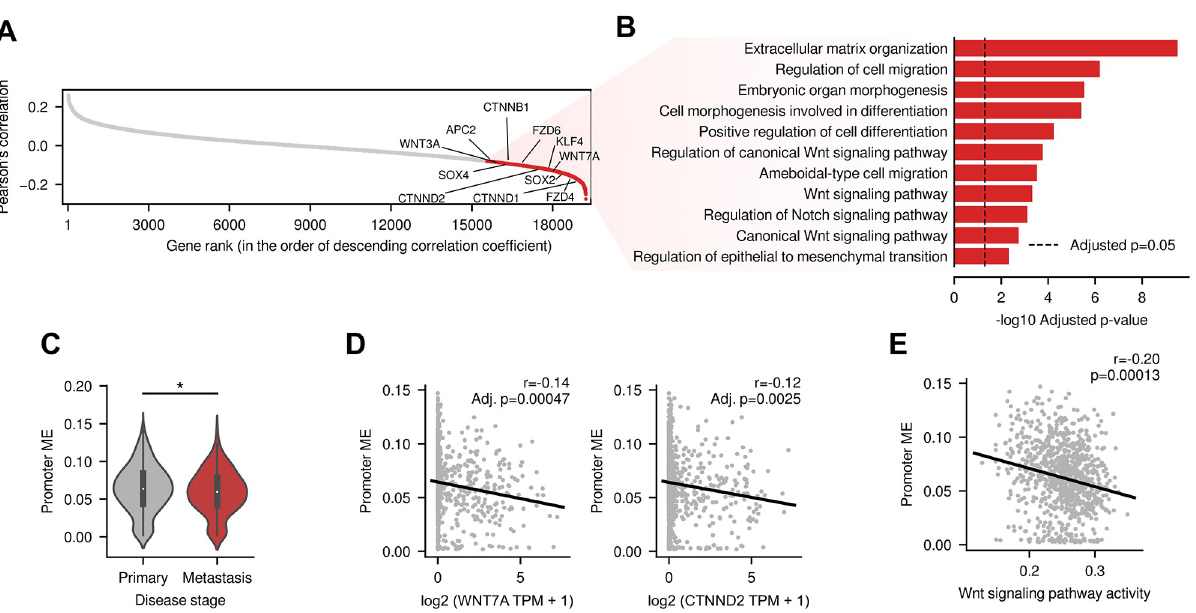
Fig 4. Association between methylation entropy and cancer stemness. (A) Genes were ranked by the Pearson’s correlation between their expression and average methylation entropy levels across promoters. Red dots represent 3,680 genes having statistically significant correlations (Benjamini- Hochberg adjusted p-value < 0.05), and the results of functional enrichment analysis using those genes are shown in (B). (C) The distribution of promoter methylation entropy levels in primary and metastatic cancer cell lines. (D) The association between promoter methylation entropy levels and two genes representative of Wnt signaling pathway ( WNT7A and CTNND2 ). (E) The association between promoter methylation entropy levels and the activity of Wnt signaling pathway. � two-tailed independent t-test p < 0.05; In D-E, Pearson’s correlation coefficients and associated p-values are shown. In D, p-values were adjusted using Benjamini-Hochberg